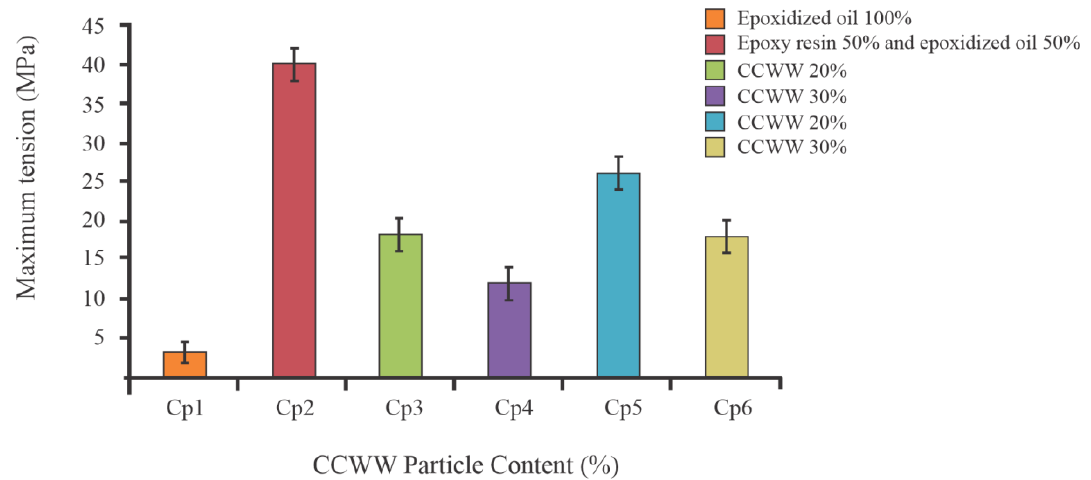
Figure 5. Ultimate tensile stress for the cured neat resins and for the produced particleboards.